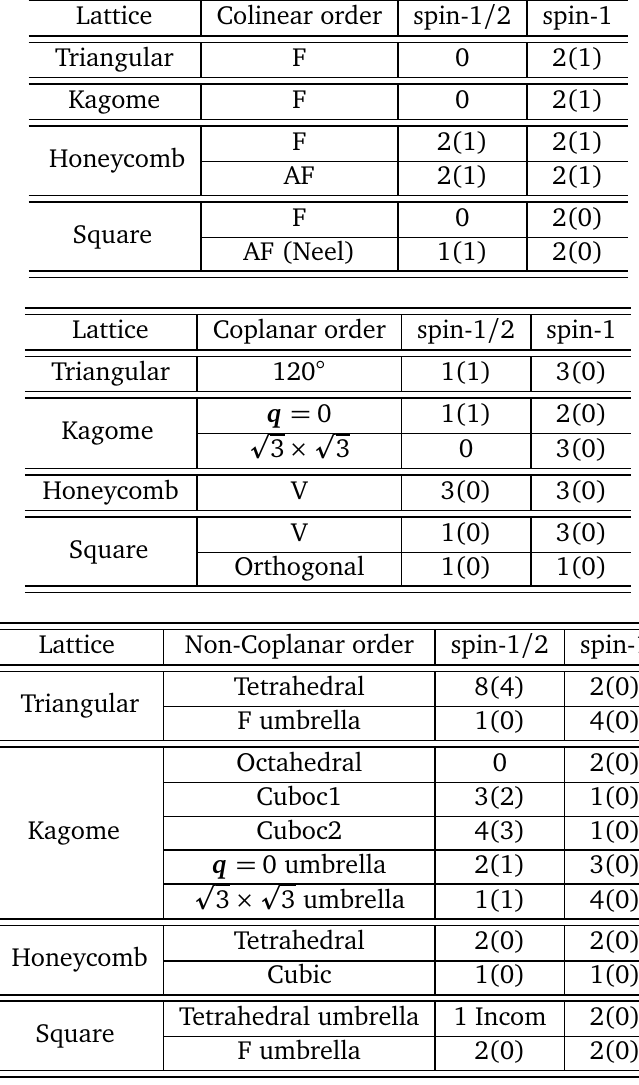
Table 2: Numbers of realizations for DQCP (top), DSL (middle) and SL ( 7 ) (bot- tom) adjacent to some colinear, coplanar and non-coplanar magnetic orders, re- spectively, of triangular, kagome, honeycomb and square lattice spin-1 / 2 (or gen- eral half-integer-spin) systems (third column) and spin-1 (or general integer-spin) systems (fourth column). The numbers in parenthesis are the numbers of stable re- alizations (defined in the same way as in Table 1). F stands for Ferromagnetic while AF stands for Anti-ferromagnetic. “1 Incom” means that realizations of SL ( 7 ) adja- cent to tetrahedral umbrella order on the square lattice spin-1 / 2 systems belong to a continuous family of realizations, where the non-magnetic components of n can have continuously changing momenta. See Appendix L for the spin configurations of these magnetic orders, and the attached code ReadMe.nb for the explicit